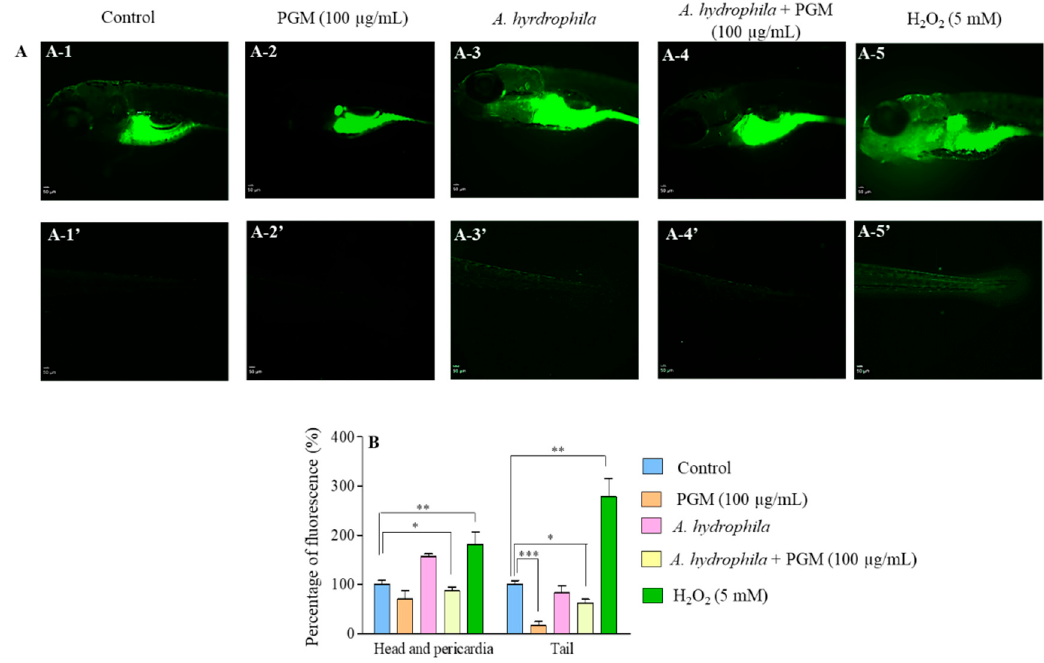
Figure 4. ROS detoxification effect of PGM on A. hydrophila –challenged zebrafish larvae. ( A